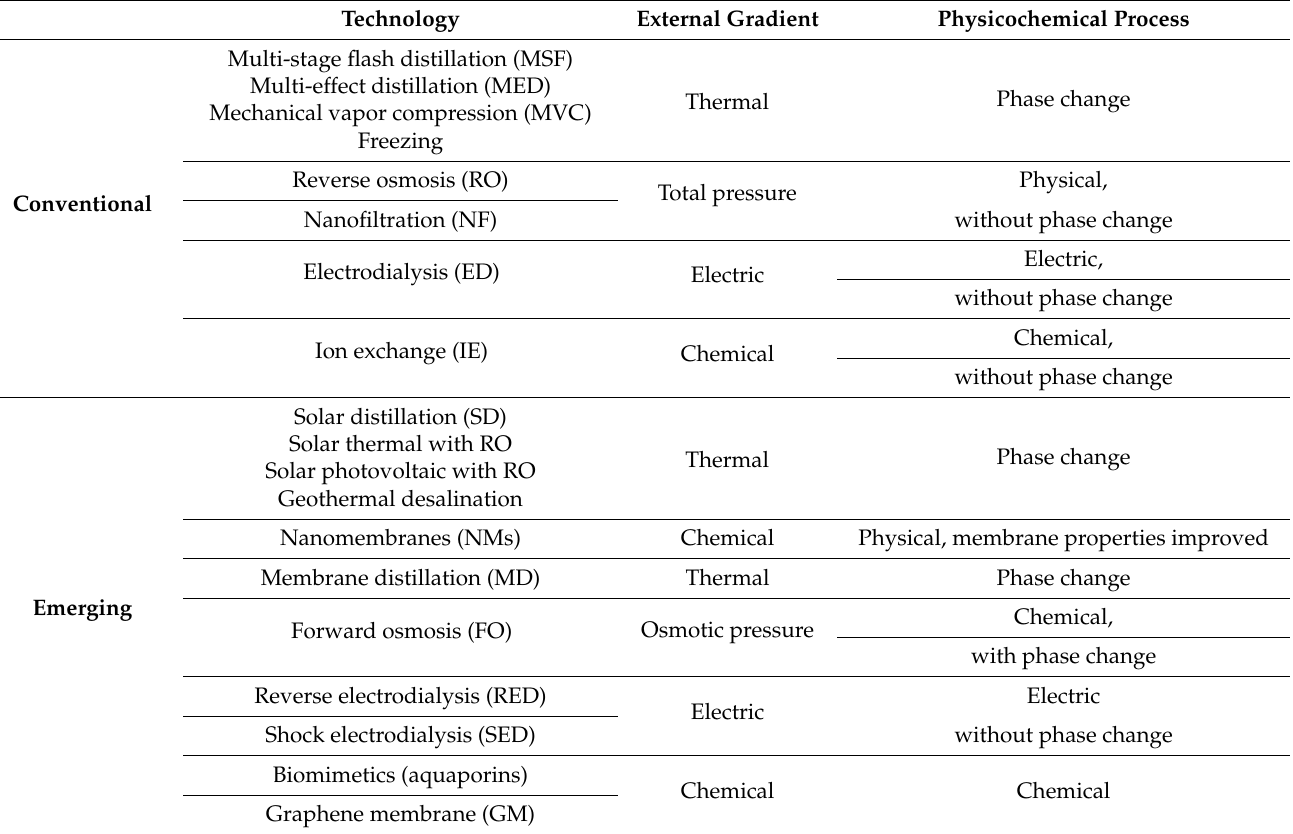
Table 1. Summary of conventional and emerging technologies for desalination according to physicochemical process and external